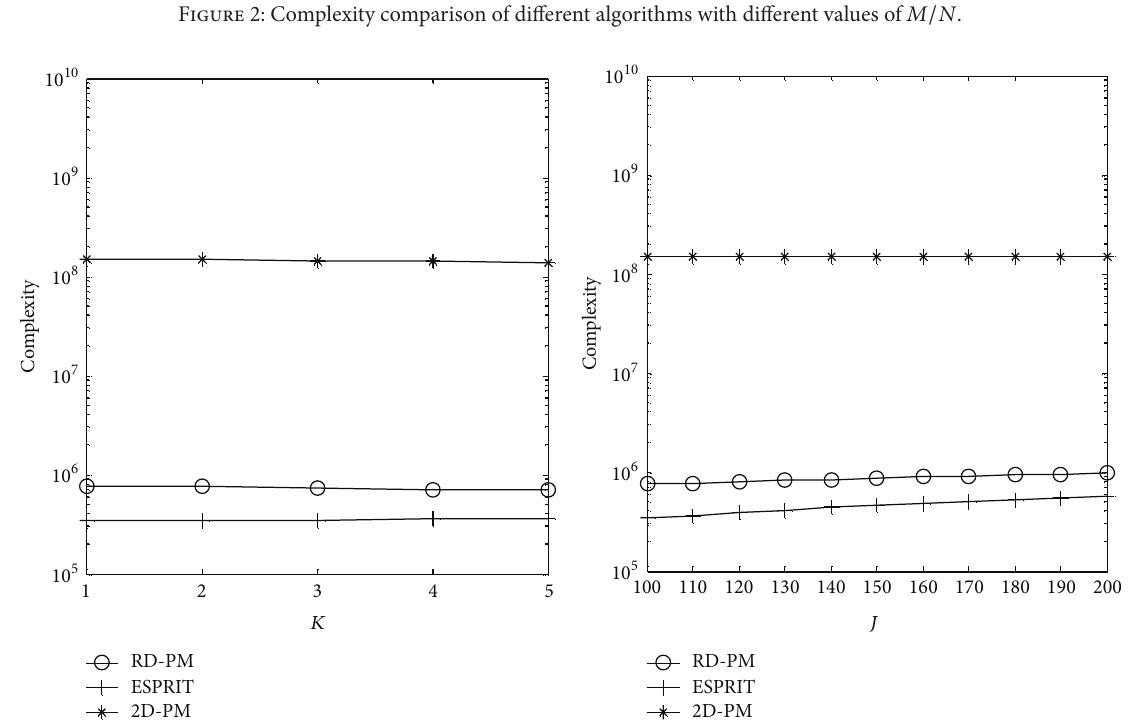
Figure 3: Complexity comparison of different algorithms with different values of 𝐾/𝐽